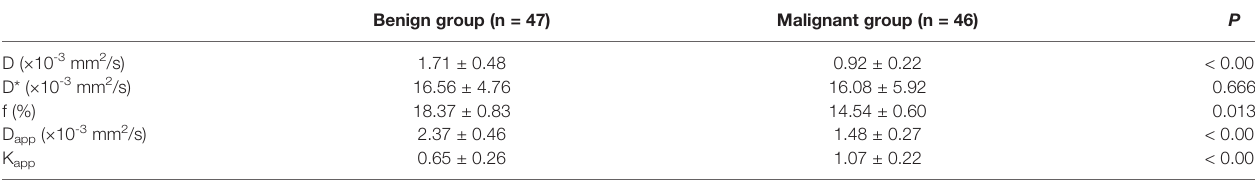
TABLE 4 | Quanti fi cation parameters of IVIM and DKI for the benign and malignant groups.